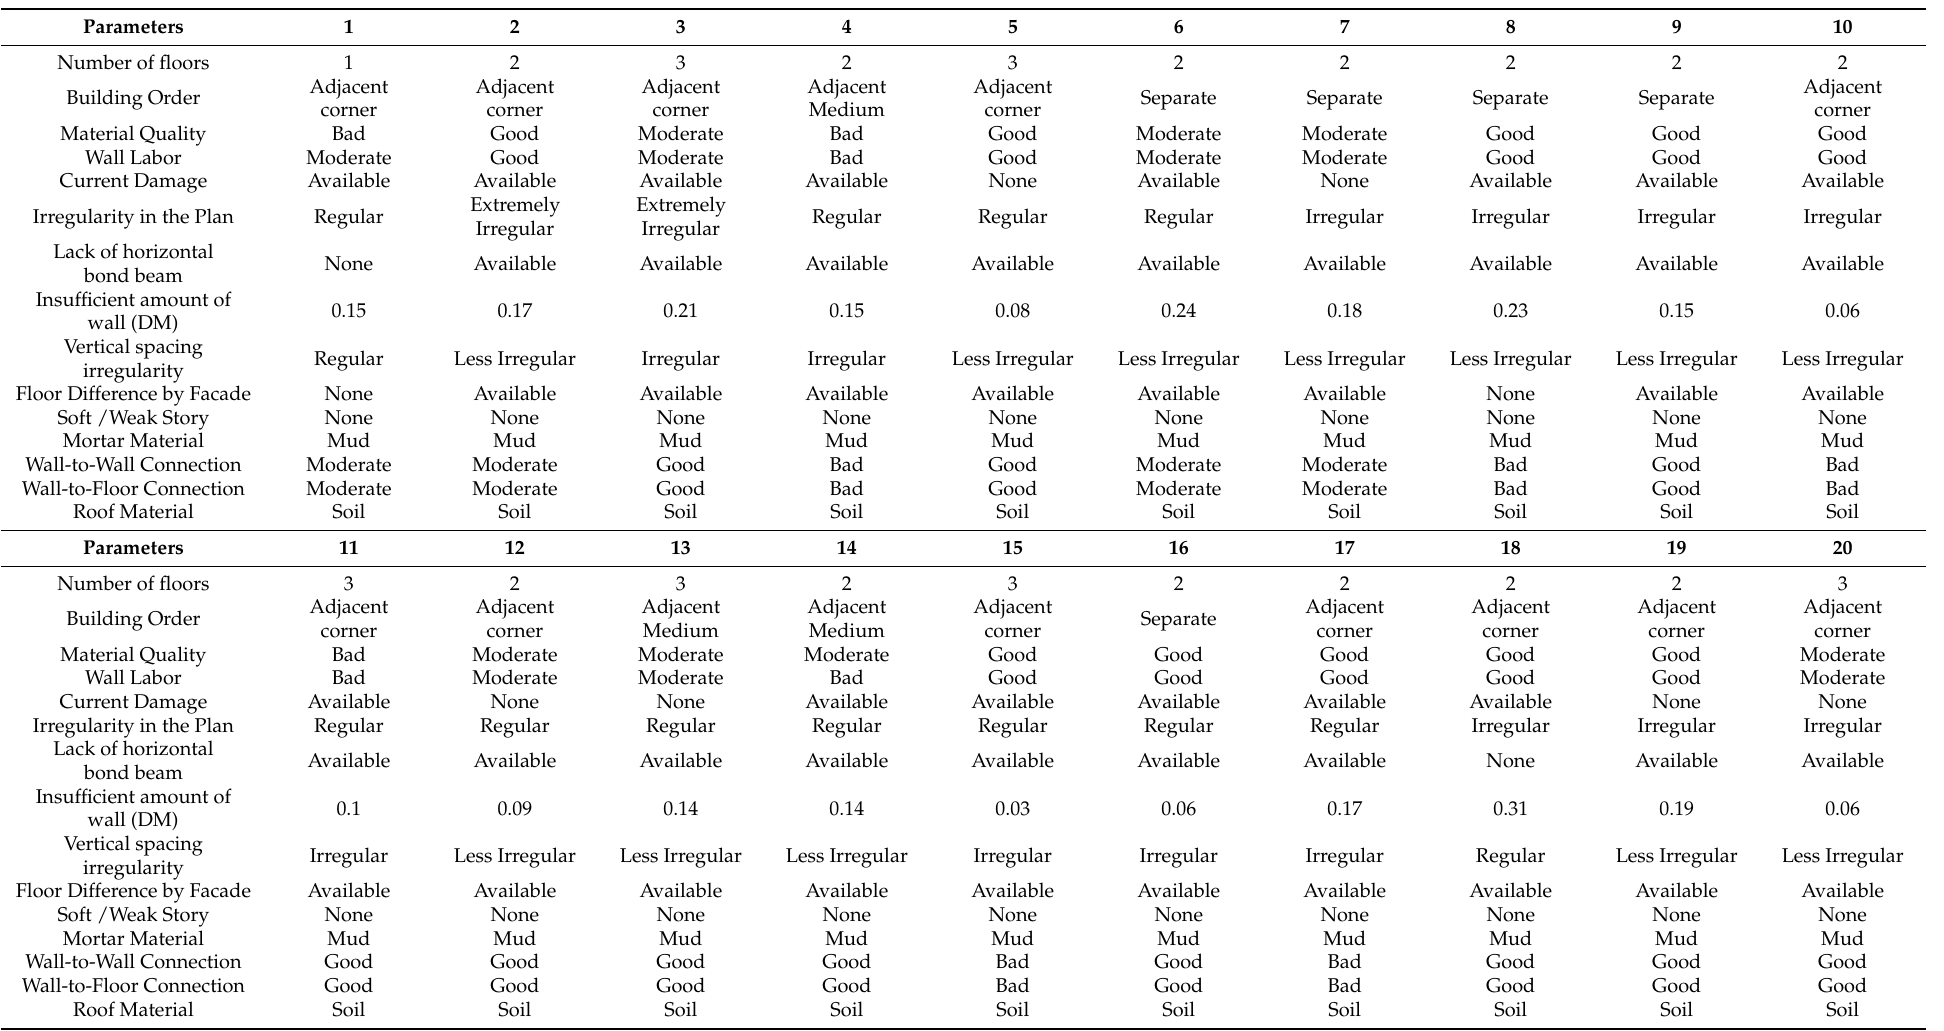
Table 13. Parameters of the investigated masonry